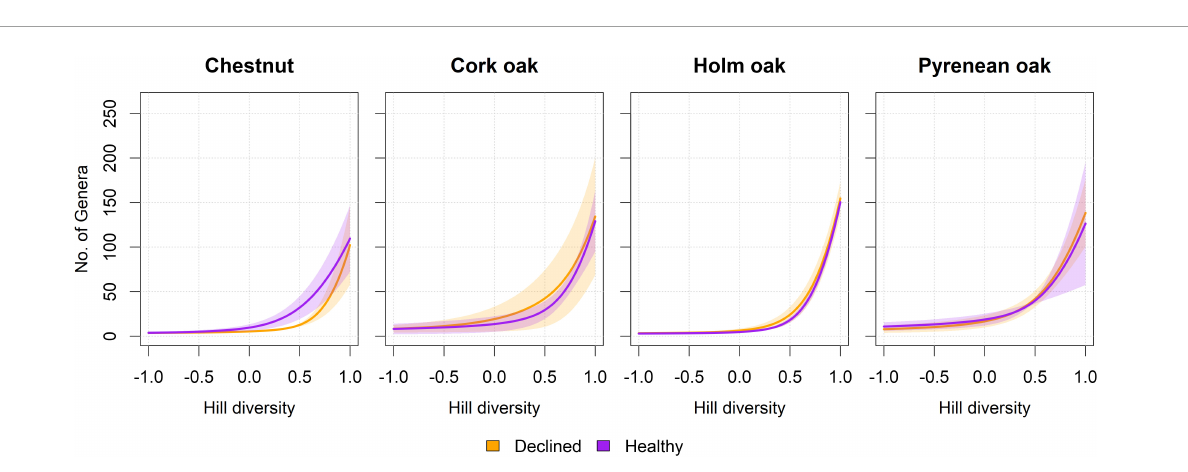
FIGURE5 Diversity profiles per tree species and health status. Curves represent the average diversity in samples from healthy and declined trees, in terms of an imaginary assemblage with that same diversity, but in which all species are equally abundant (Jost, 2006; Roswell et al., 2021). The horizontal axis represents the exponent l of Hill diversity, which can be interpreted as equivalence-corrected versions for richness ( l = 1), Shannon ( l = 0), and Simpson ( l = –1) diversity estimators. Shadowed intervals correspond to standard error. No significant differences were found at l = [1, 0, –1] (Wilcoxon test, n = 3 per tree species and health condition, p > 0.05). Raw curves prior to averaging can be found in Supplementary Figure 3